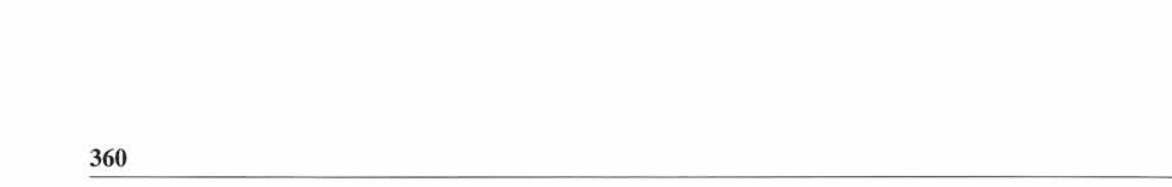
Table 3. Atomic coordinates and displacement parameters (in Â 2